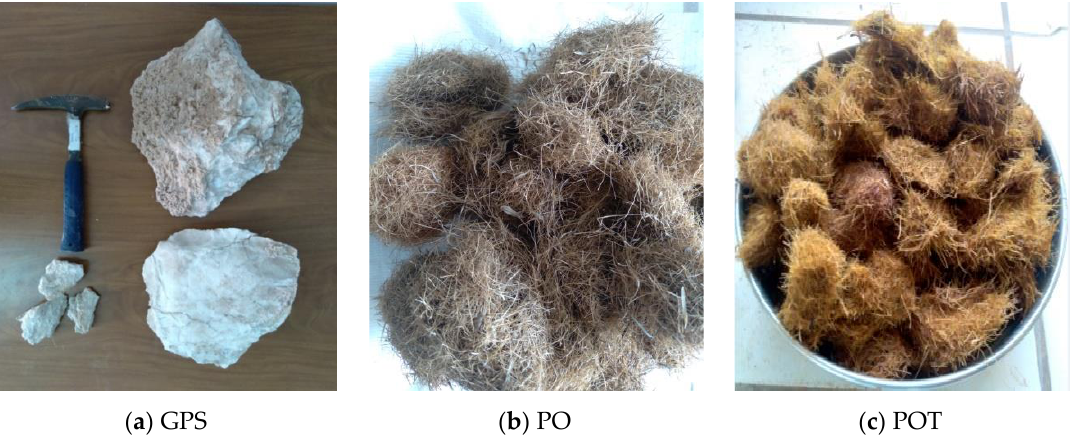
Figure 1. ( a ) The slices of gypsum (GPS), ( b ) Posidonia oceanic fibers (PO), and ( c ) the treated Posidonia oceanica fibers (POT).